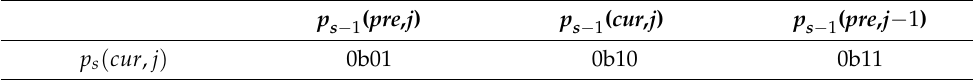
Table 1. Definition of the higher two-digit data term for tree node p s ( cur, j ).